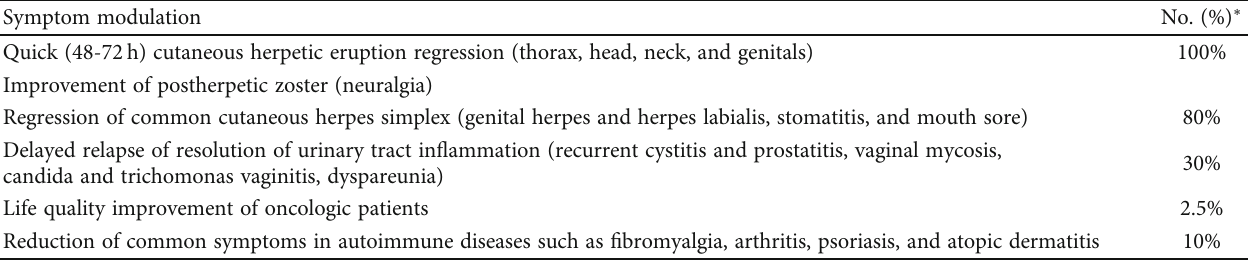
Table 3: Clinical outcome of the treatment in symptomatic patients. E ff ects of Parvulan injection on the no. of patients (%). Symptom modulation